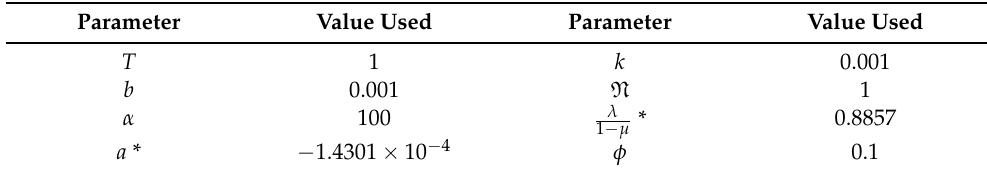
Table 4. Liquidation parameters for Google stock.